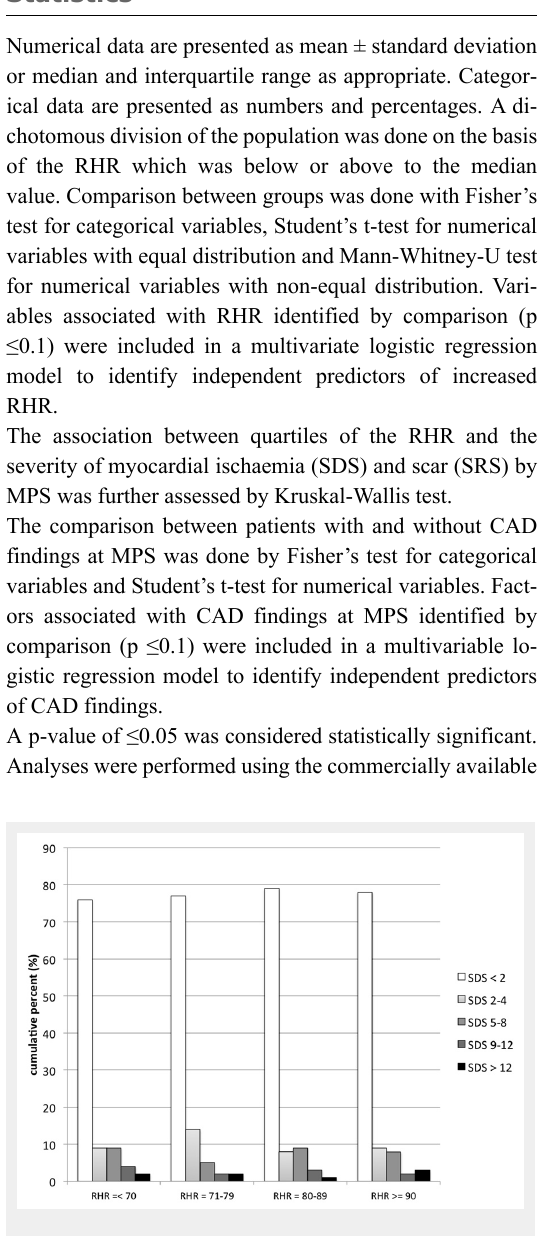
Graphics illustrating the interrelation between the quartiles of resting heart rate (RHR in bpm) and the severity of myocardial ischaemia